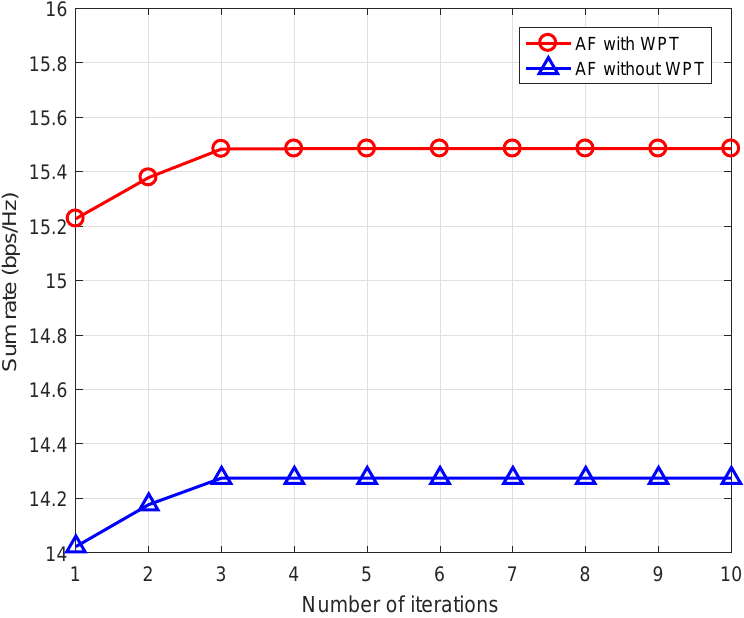
Figure 2. Convergence behavior of the proposed algorithm ( N = 4, d sr = 1 m and d rd = 50